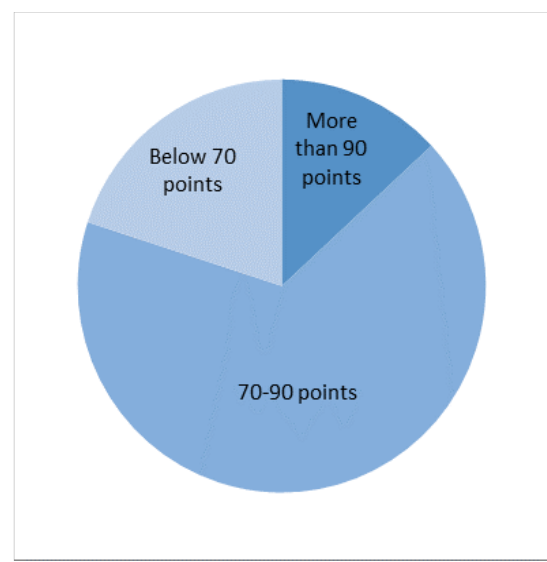
Figure2. Distribution of collection accuracy